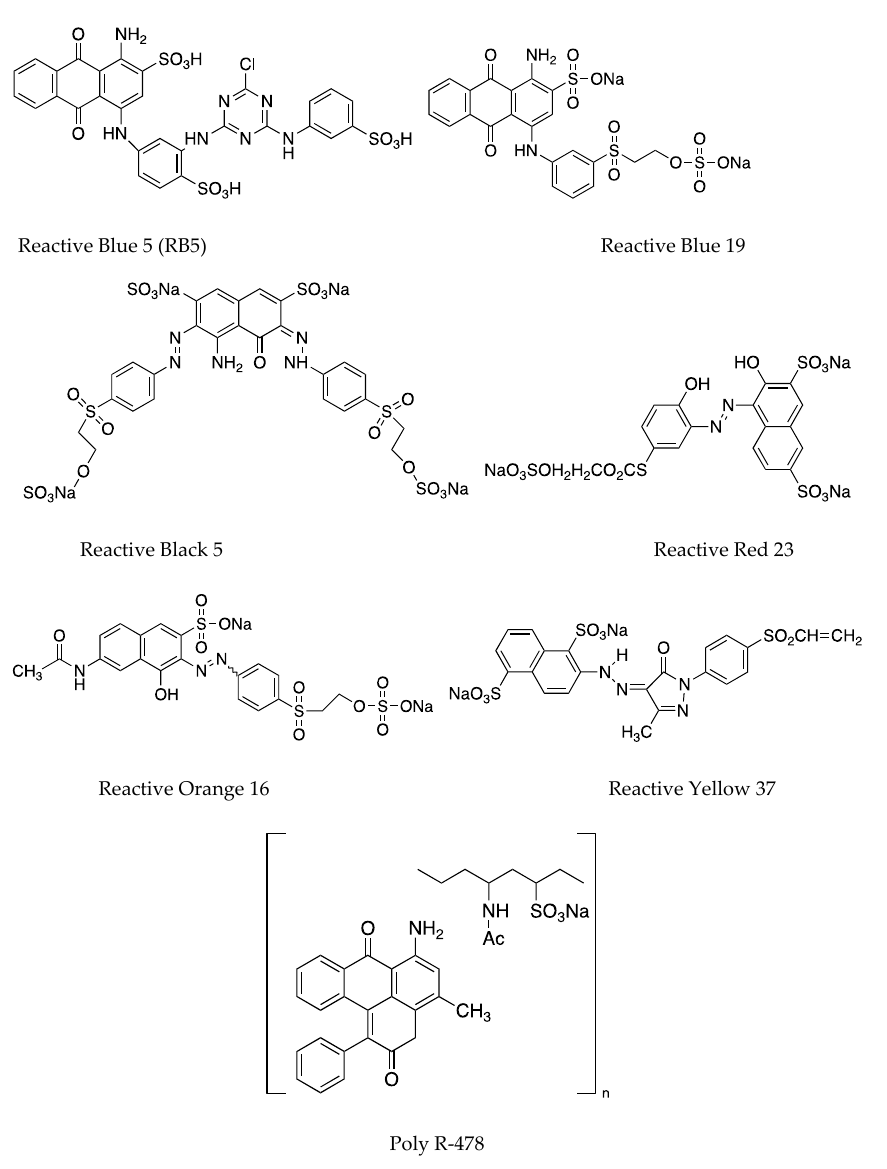
Figure 1. Structures of the dyes used in the study. Reactive Blue 5 (RB5) and Reactive Blue 19 represent the anthraquinone dyes. Reactive Black 5, Reactive Red 23, Reactive Orange 16, and Reactive Yellow 37 represent the azo dyes. Poly R-478 represents an anthraquinone-based polymeric